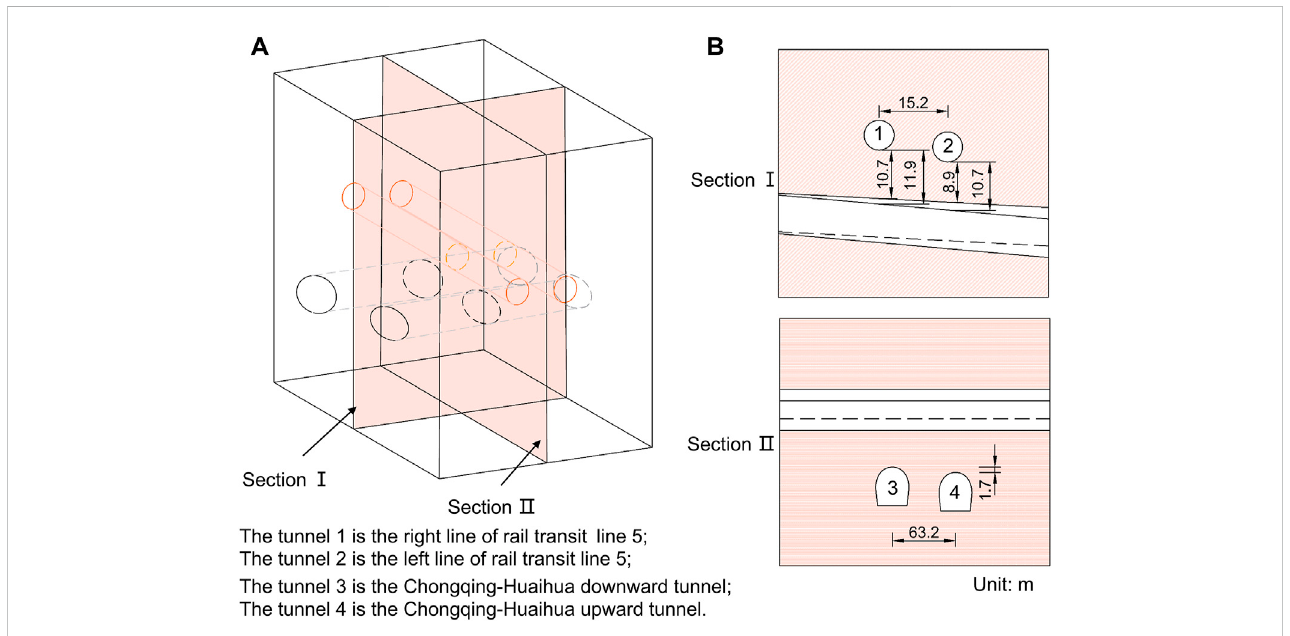
FIGURE 5 Spatial position relationship of the complex adjacent tunnel. (A) Overall schematic diagram. (B) Section diagram.